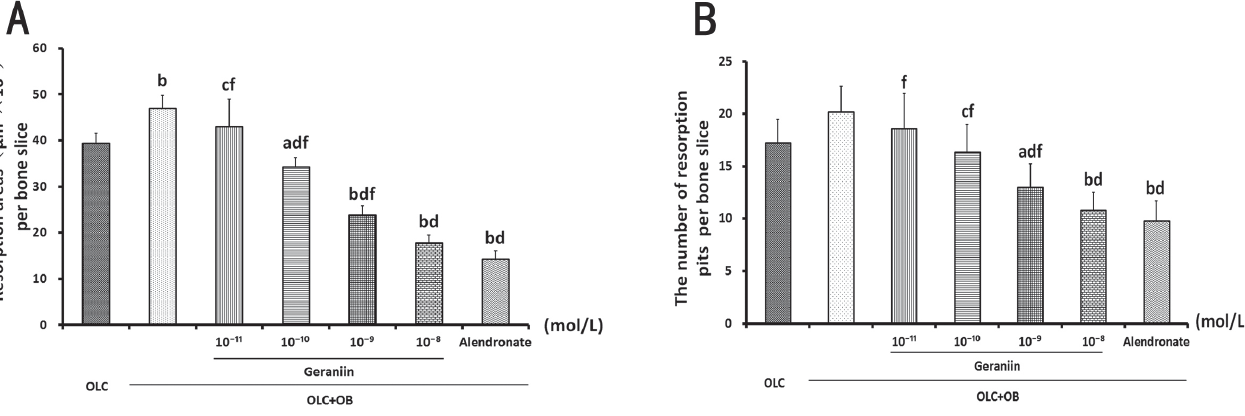
FIGURE 5 - Effects of geraniin on bone resorption in OLC-OB co-culture system. Geraniin (10 -11 -10 -8 mol/L) concentration- dependently inhibited the resorption areas (A) and the number of resorption pits (B) per bone slice. Values are mean ± S.D. a P < 0.05, b P < 0.01 versus OLC group, c P < 0.05, d P < 0.01 versus OLC+OB group, e P < 0.05, f P < 0.01 versus between medicated group and alendronate